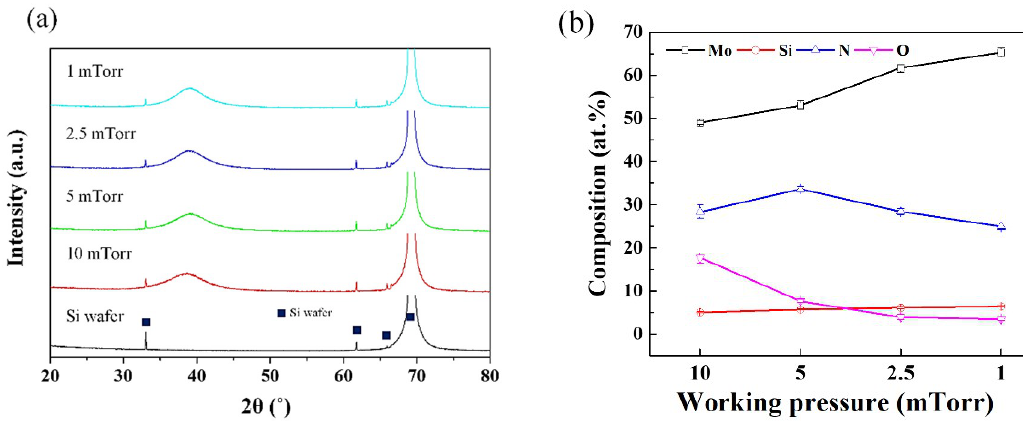
Figure 4. ( a ) XRD patterns and ( b ) energy-dispersive X-ray spectroscopy (EDS) results of the Mo–Si–N coatings produced under various working pressures of 10, 5, 2.5, and 1 mTorr, retaining the N 2 gas flow ratio of 25%.